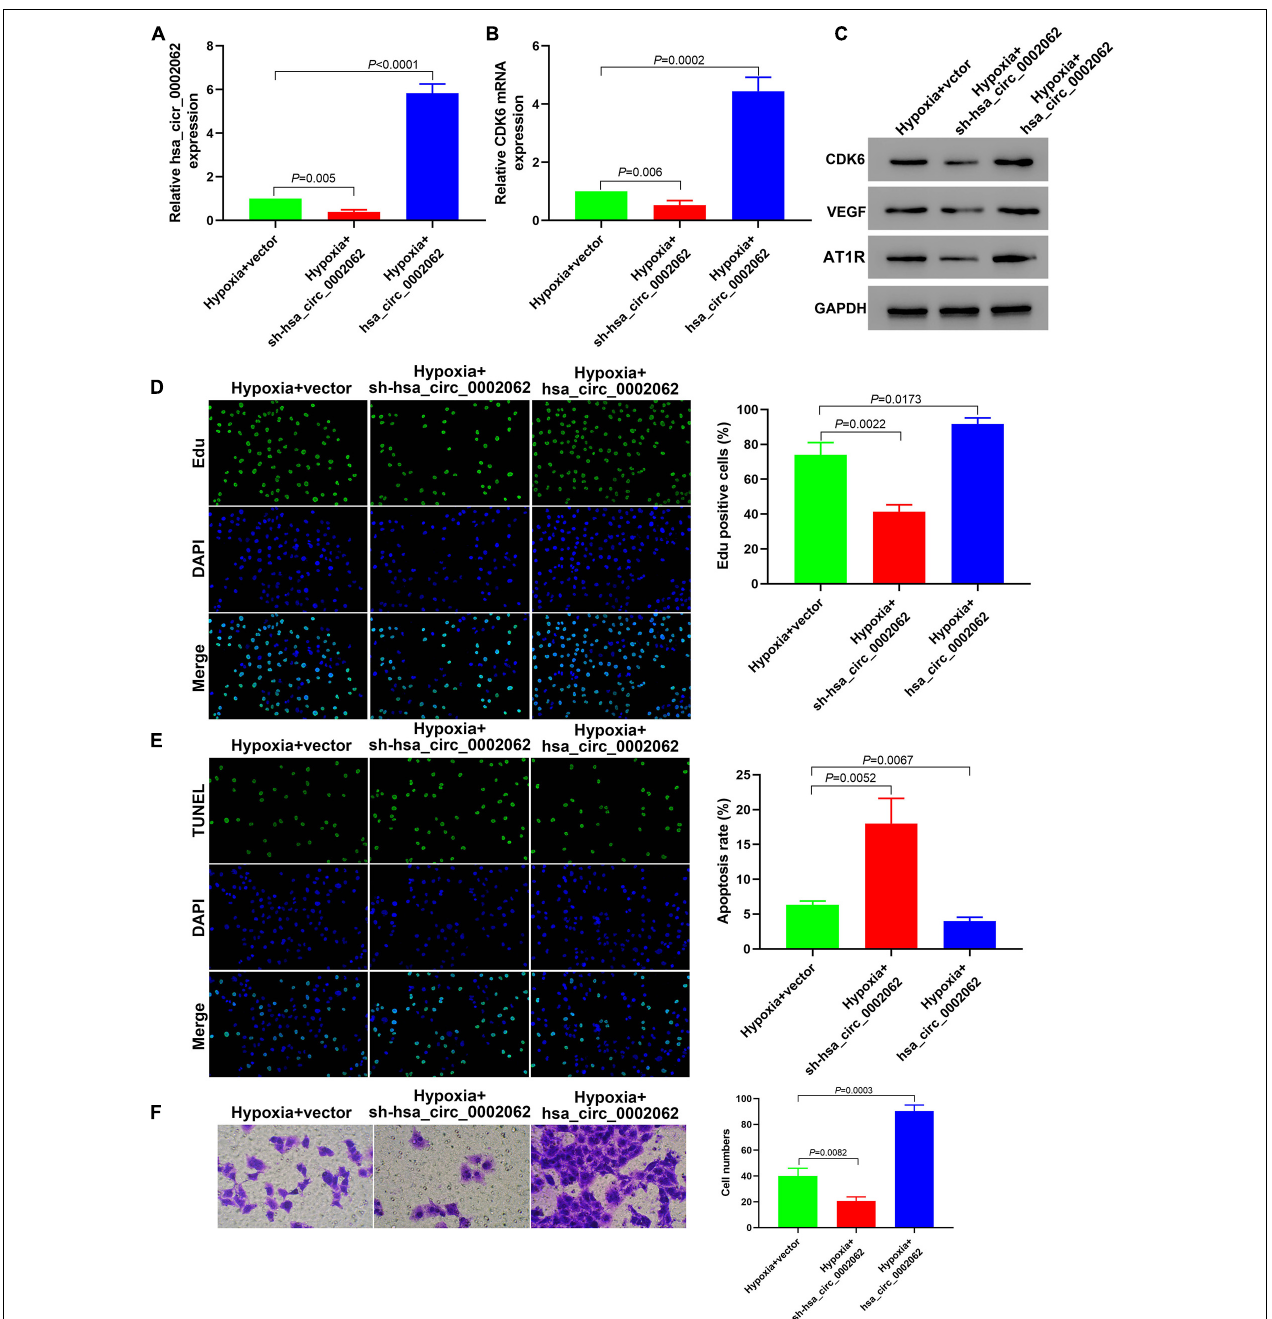
FIGURE 2 | Downregulation of hsa_circ_0002062 expression in hPASMCs under hypoxia attenuates cell proliferation and migration. (A) qRT-PCR indicated successful silencing or overexpression of hsa_circ_0002062. (B,C) The mRNA levels of CDK6 and the protein levels of CDK6, VEGF and AT1R were significantly decreased in cells treated with sh-hsa_circ_0002062, whereas they were increased in cells overexpressing hsa_circ_0002062 (all p < 0.01). (D–F) Edu assay (D) , TUNEL assay (E) , and Transwell assay (F) , indicating that cell proliferation and migration were elevated while the apoptosis rate in hypoxia hPASMCs was lowered in the overexpressed hsa_circ_0002062 group, in contrast to the control group. Knockdown of hsa_circ_0002062 with shRNA restrained proliferation and migration while stimulated the apoptosis of hypoxic hPASMCs. Error bars represent the mean ± SD from triplicate experiments. Image magnification: × 200.